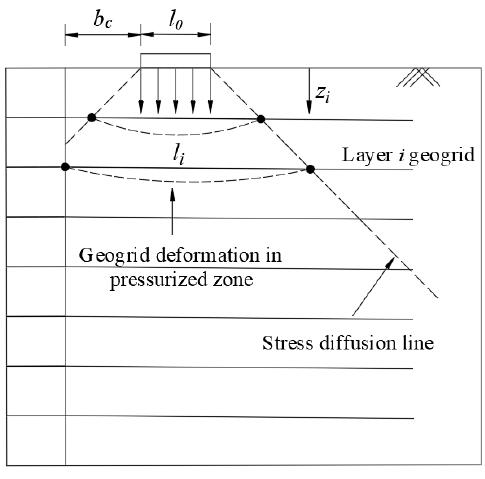
Figure 13. Deformation diagram of geogrid in pressurized zone.